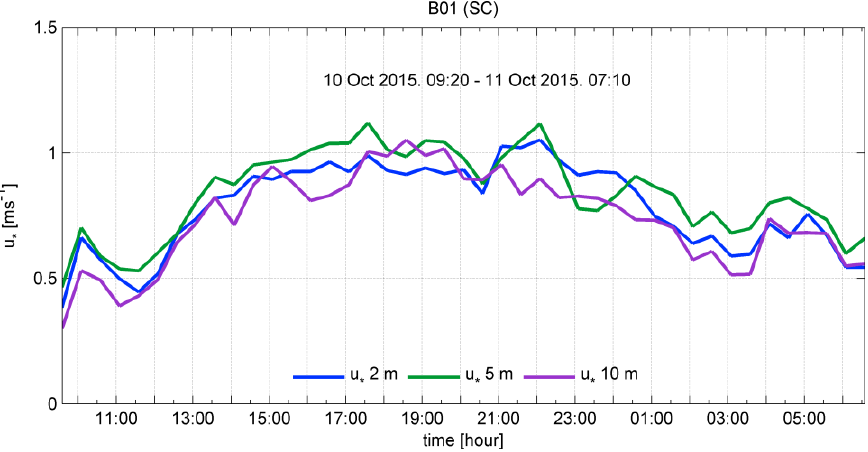
Figure 13. The time series of friction velocity ( 𝑢 ∗ ) for bora B01 (SC). The blue line is 𝑢 ∗ at 2 m, the green line is at 5 m, and the magenta line is at 10 m.